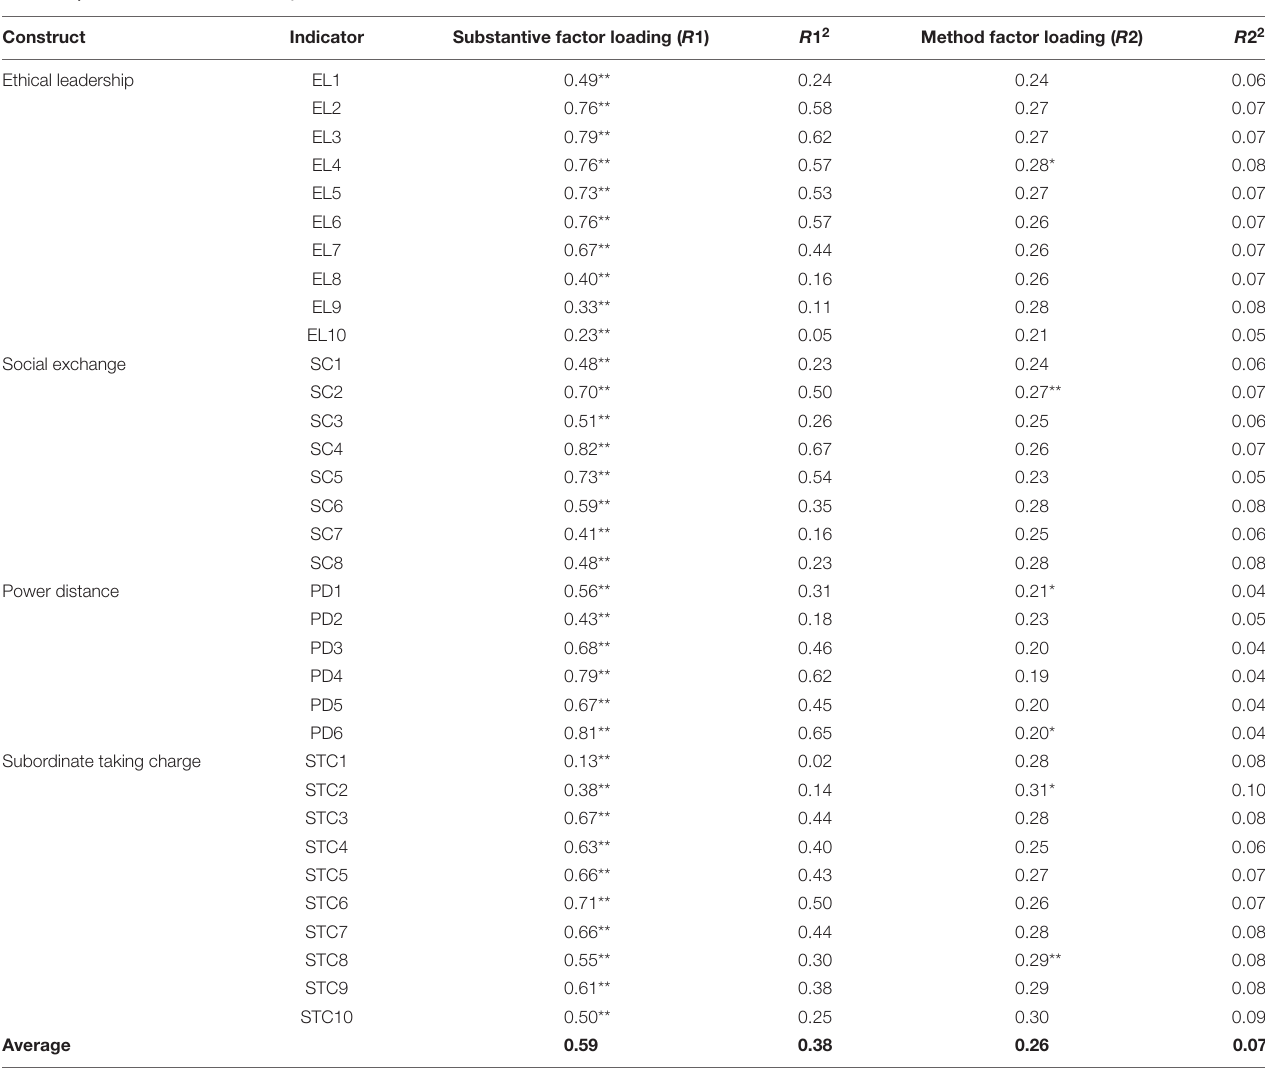
TABLE 2 | Common method bias